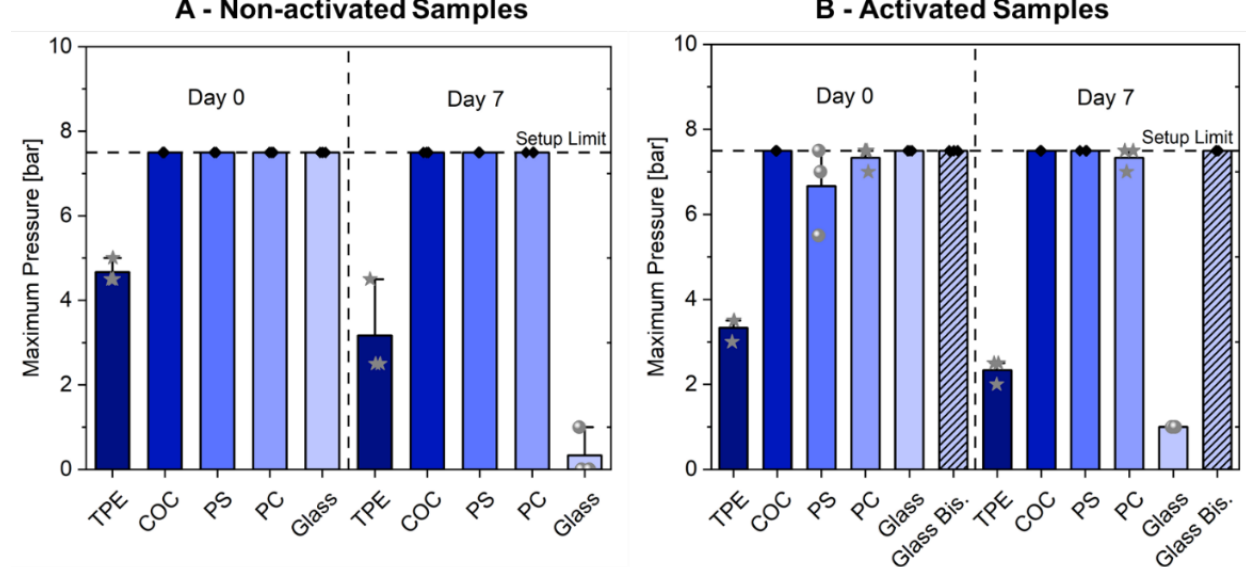
Figure 2. Maximum working pressure ( A ) non-activated samples and ( B ) activated samples bonded to different substrates are able to withstand. Day 0 refers to devices tested right after the overnight thermal bonding. Day 7 refers to devices stored for one week submersed in PBS at 37 ◦ C. The star-labeled data points belong to devices that failed due to material deformation, while spheres belong to devices that resulted in delamination from the substrate. Samples labeled with a black circle reached the maximum pressure of the setup without any form of failure. For each condition, three independent experiments were conducted (only for PS, non-activated, day 0: N = 2).